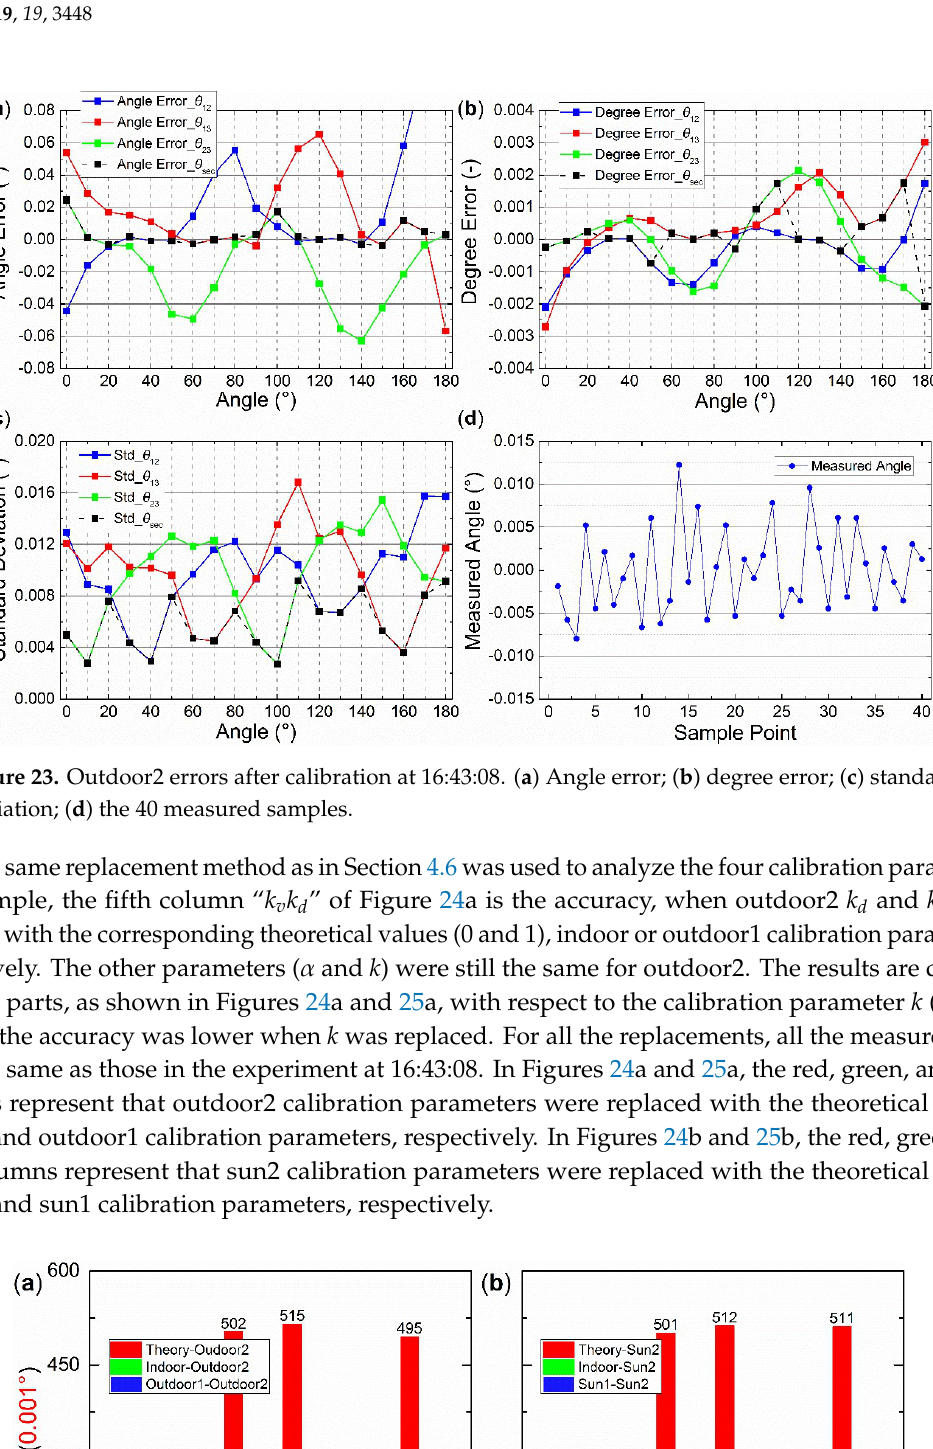
Figure 22. Photograph of outdoor setup.